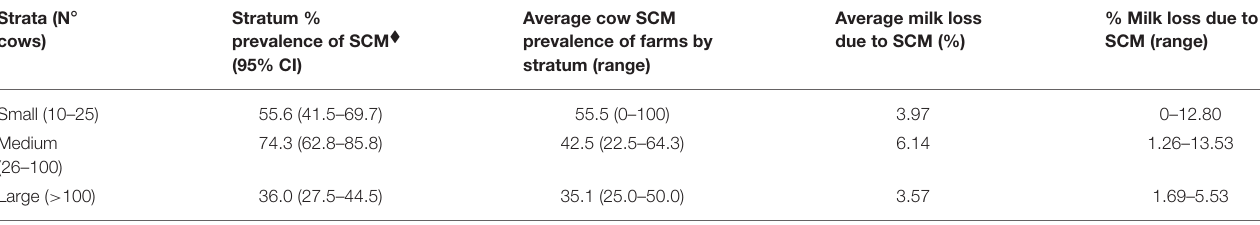
TABLE 2 | Prevalence of SCM and milk losses in farms per stratum in the Bogota plateau. Strata (N ◦